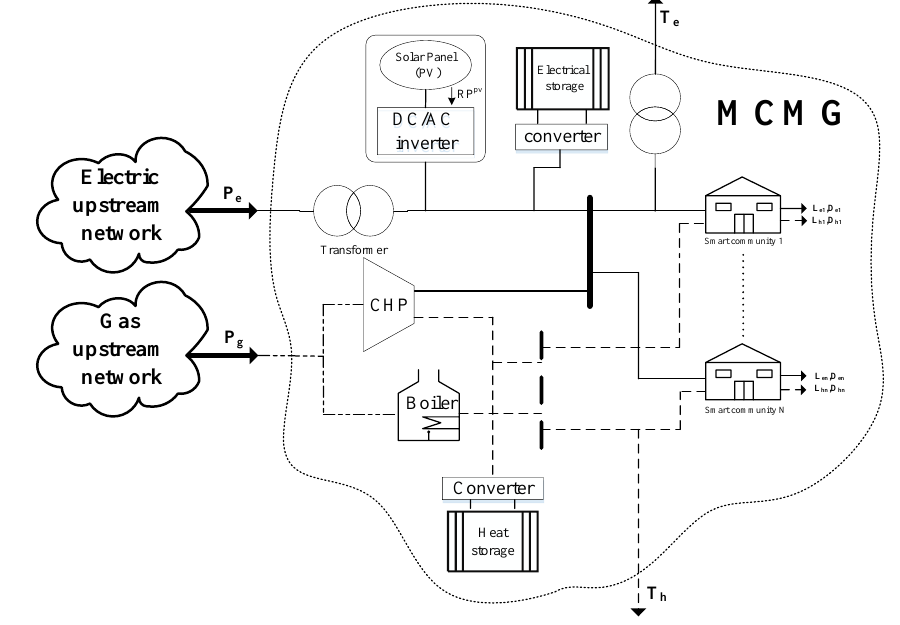
Figure 2. Sampled MCMG structure.